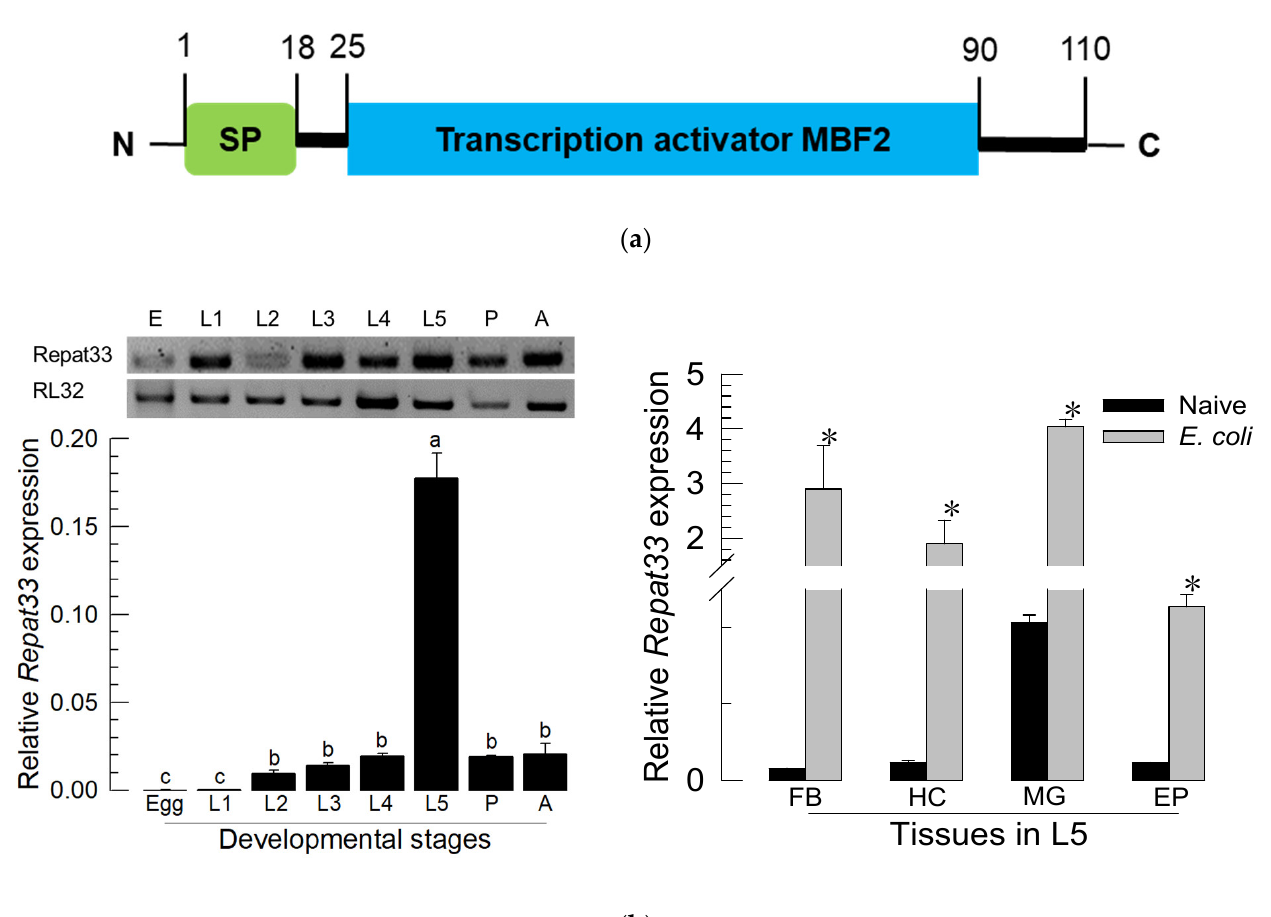
Figure 2. Expression profile of Repat33 in S. exigua . ( a ) Domain analysis. ‘SP’ stands for signal peptide. ( b ) Expression levels of Repat33 in different developmental stages including egg, first to fifth instar larvae (‘L1-L5′), pupa (‘P’), and adult (‘A’), and different tissues of L5 including the fat body (‘FB’), hemocyte (‘HC’), midgut (‘MG’), and epidermis (‘EP’). For the immune challenge, E. coli (10 4 cells/larva) was injected into L5 larvae followed by incubation for 8 h at 25 °C. A ribosomal gene, RL32 , was used as a reference gene. Each treatment was replicated three times with independent biological sample preparations. Different letters in developmental analysis indicate significant differences among means at Type I error = 0.05 (LSD test). Asterisks in tissue analysis indicate a significant difference between naïve and immune challenge.